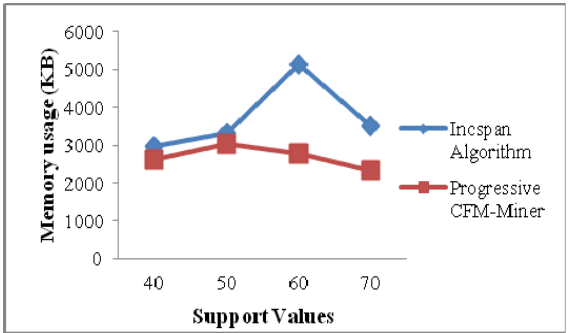
Fig.8. Memory Usages with Different Support Values